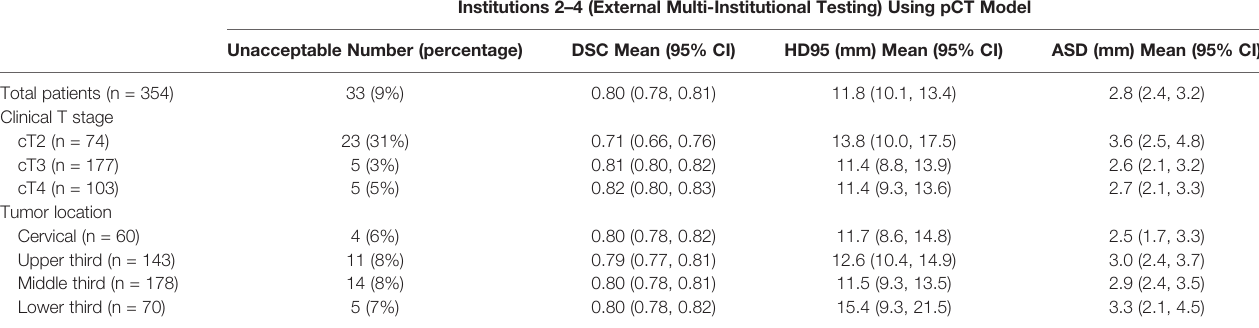
TABLE 4 | Quantitative results of esophageal GTV segmentation by the pCT model in the multi-institutional external testing data. Institutions 2 – 4 (External Multi-Institutional Testing) Using pCT